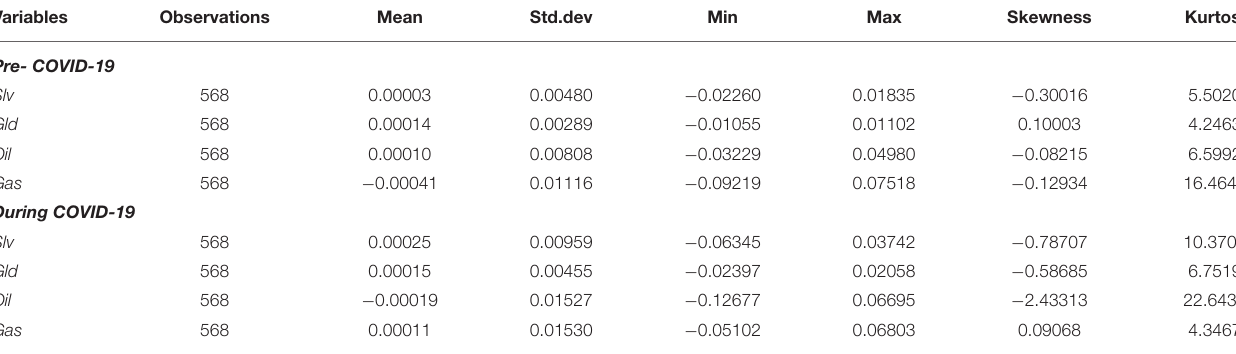
TABLE 2 | Description statistics.